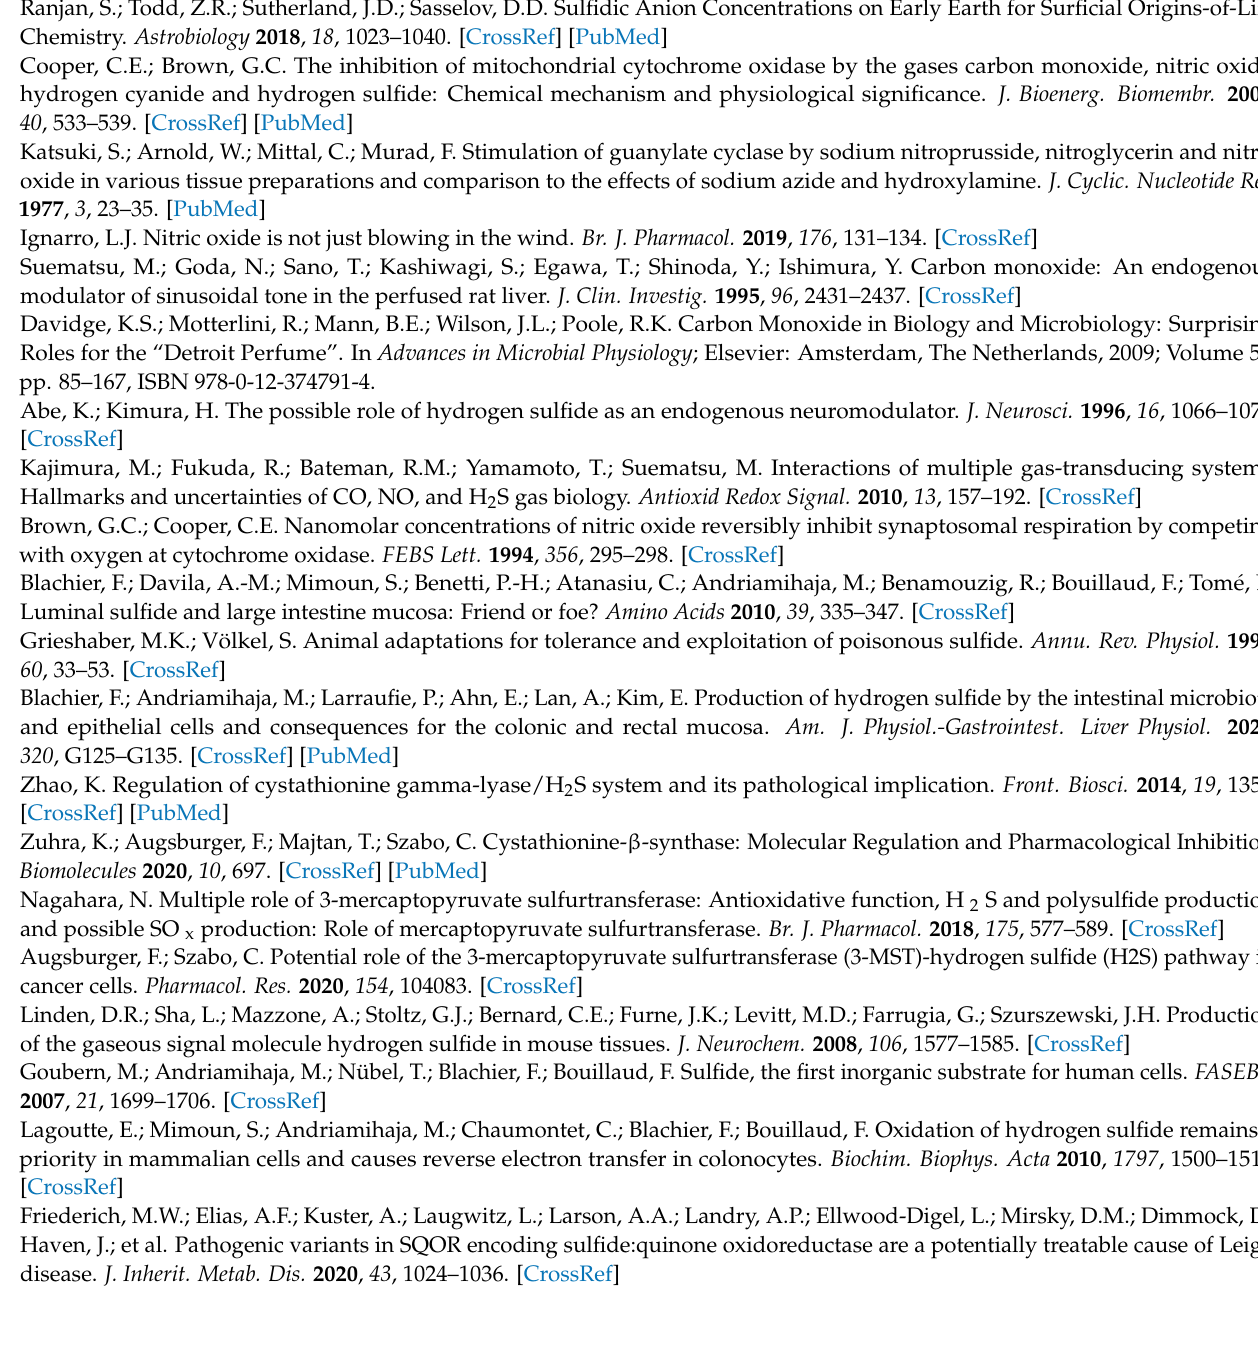
nM sulfide; Figure S2: Impact of sulfide oxidation under oxygen limitation; Figure S3: Colored version of Figure 3; Figure S4: Colored version of Figure 4; Figure S5: Colored version of Figure 5; Figure S6: Colored version of Figure 6; Figure S7: Colored version of Figure 7; Figure S8: Colored version of Figure 8; Figure S9: Colored version of Figure 9; Figure S10: Colored version of Figure 10; Figure S11: Model for sulfide permeation and cellular